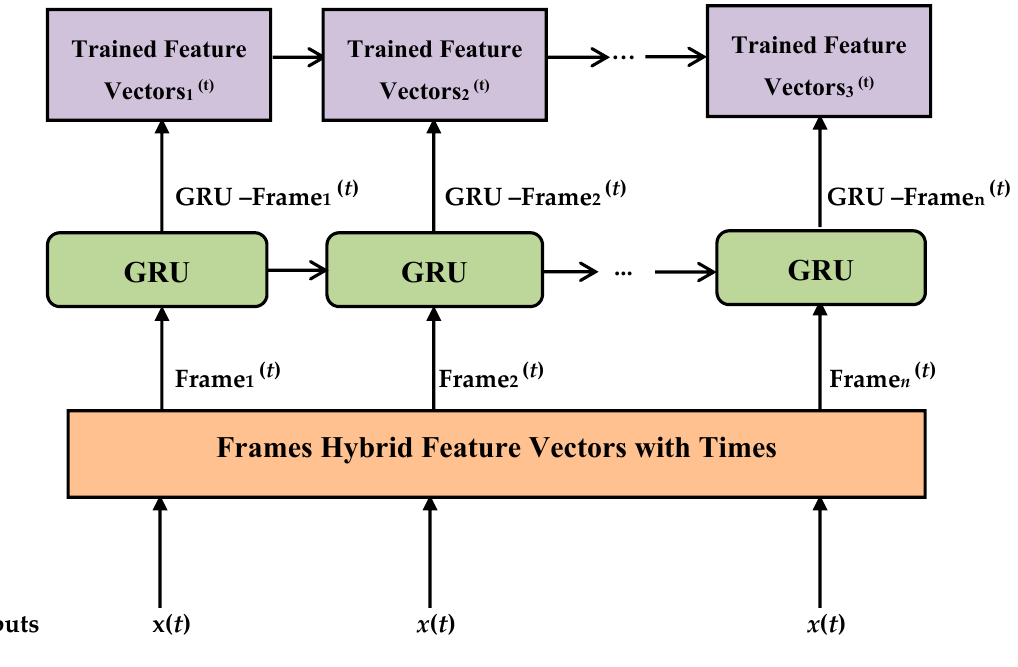
Figure 2. Proposed GRU-based framework.